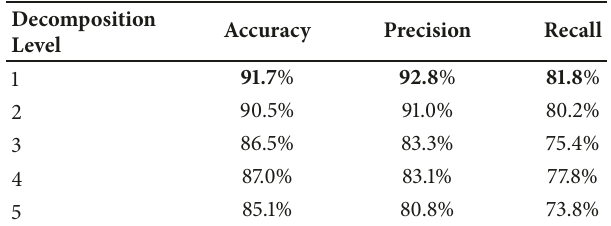
Table 5: The performance of DWT-SVM with different decompo- sition